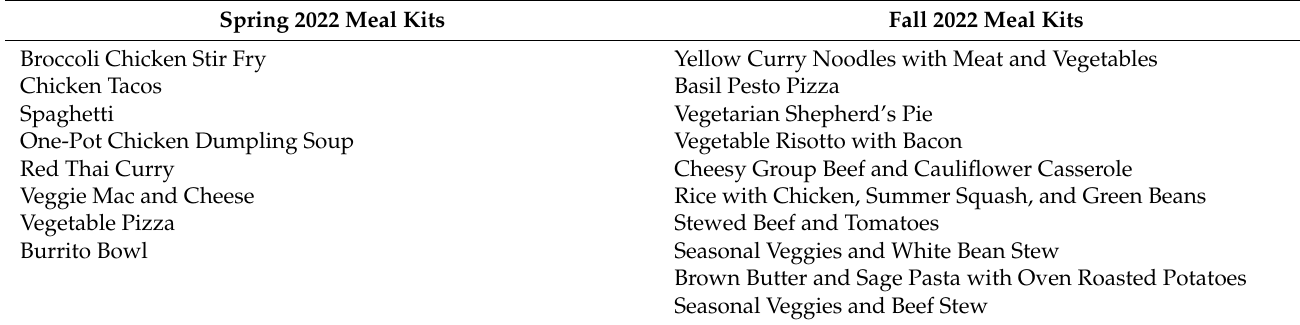
Table 2. Food Forward Meal Kits Delivered in 2022.